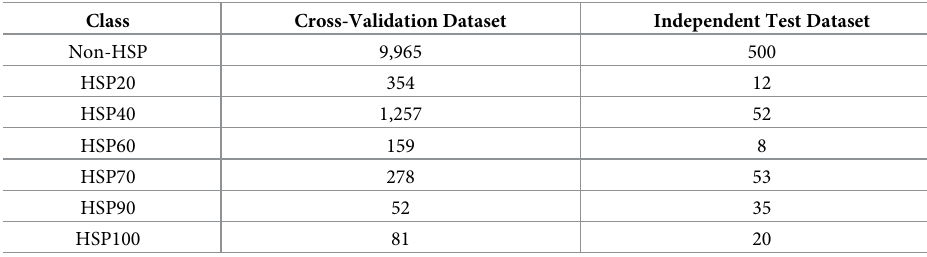
Table 3. Summary of cross-validation and independent test